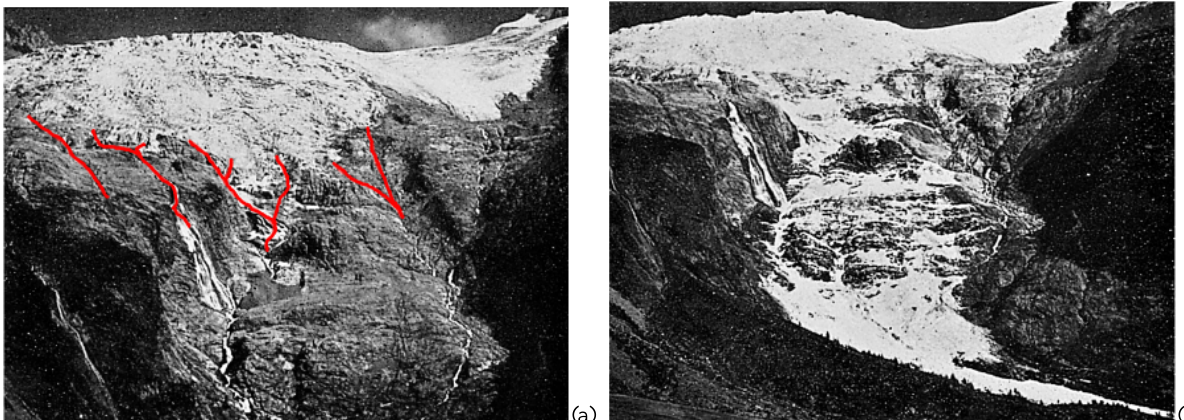
Fig. 15. Glacier du Tour in 1949 (a) before the break-off (the possible drainage network highlighted in red) (b) after the break-off, after Glaister (1951).